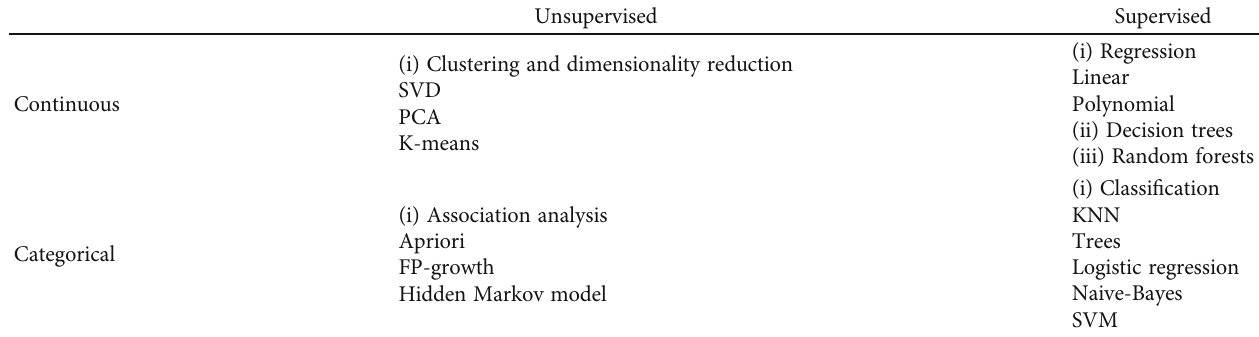
Table 2: Machine learning